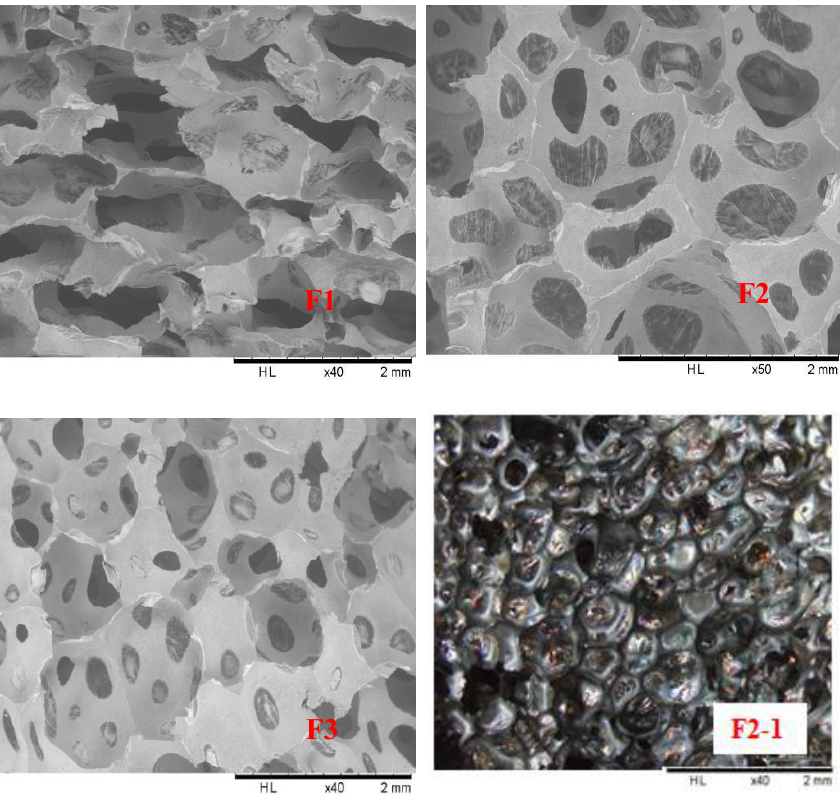
Figure 4. F1: SEM pictures of furanic-glyoxal foams (F1, F2, and F3) and microscope picture of F2 foam (F2-1).